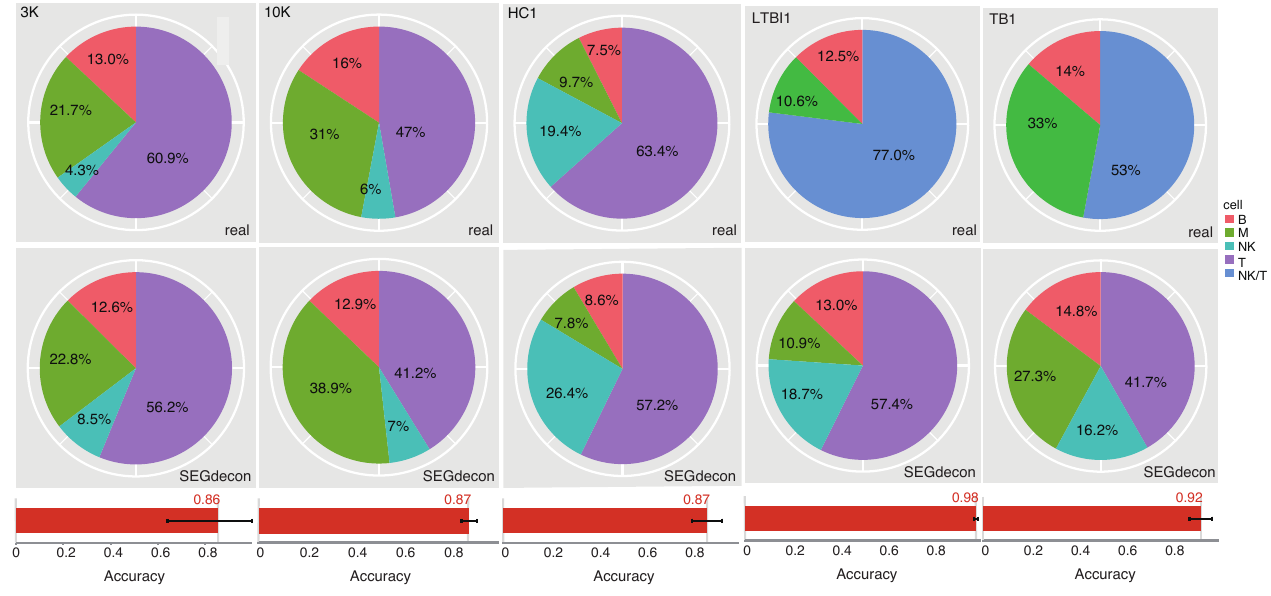
Figure 6. Performance of the SEGdecon model. SEGdcon was used to predict the proportion of major immune cells in PBMC samples. Each testing dataset was shown in a column. The real and predicted composition percentages of each major immune cell type were shown in the pie charts. The average accuracy was shown at the bottom for each testing